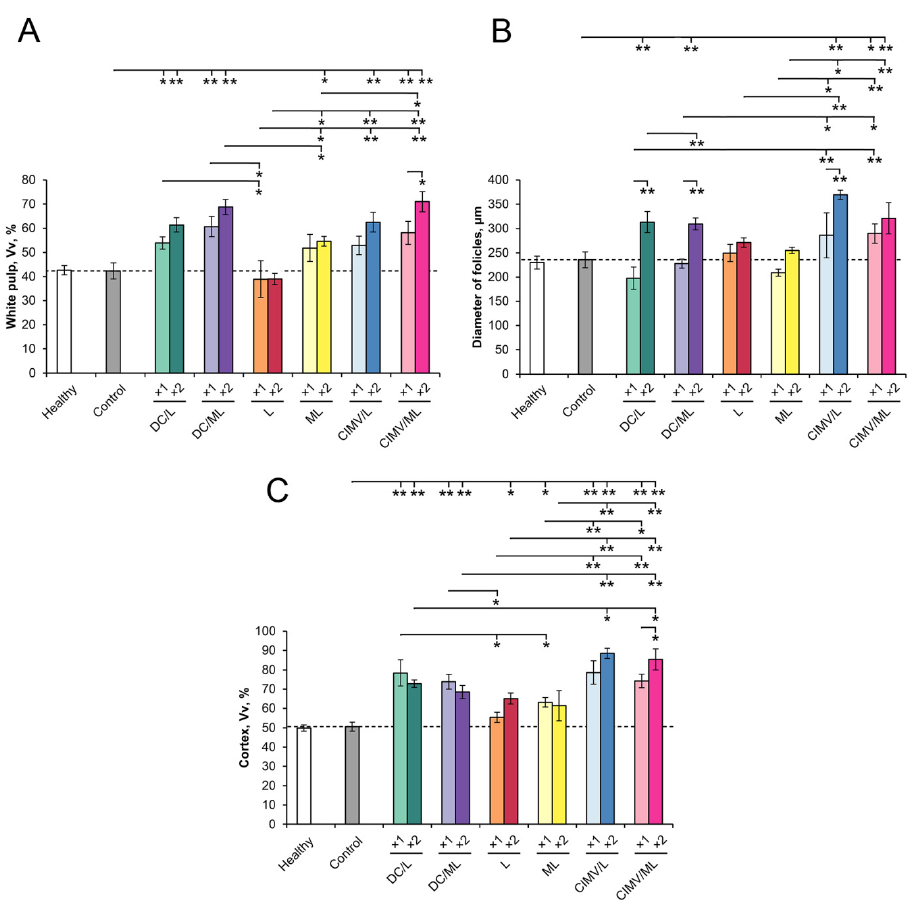
Figure 6. Spleen and thymus morphometry of RLS 40 lymphosarcoma-bearing mice without treat- ment (control) and after vaccine administration. ( A ) Volume density of white pulp in the spleen. ( B ) Diameter of lymphoid follicles in the spleen. ( C ) Volume density of the cortex in the thymus. Dash lines represent the levels of the control group. Data are presented as mean ± S.E.M. Data were sta- tistically analyzed using one-way ANOVA with post-hoc Fisher test. Statistically reliable differences between the groups: * p < 0.05, ** p < 0.005.